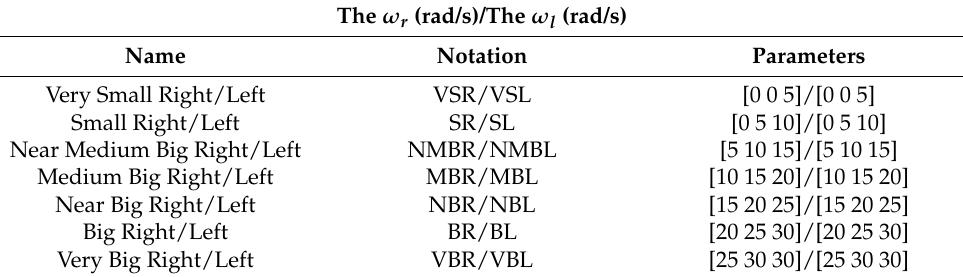
Table 9. Parameters for outputs of the expert-based FLC.